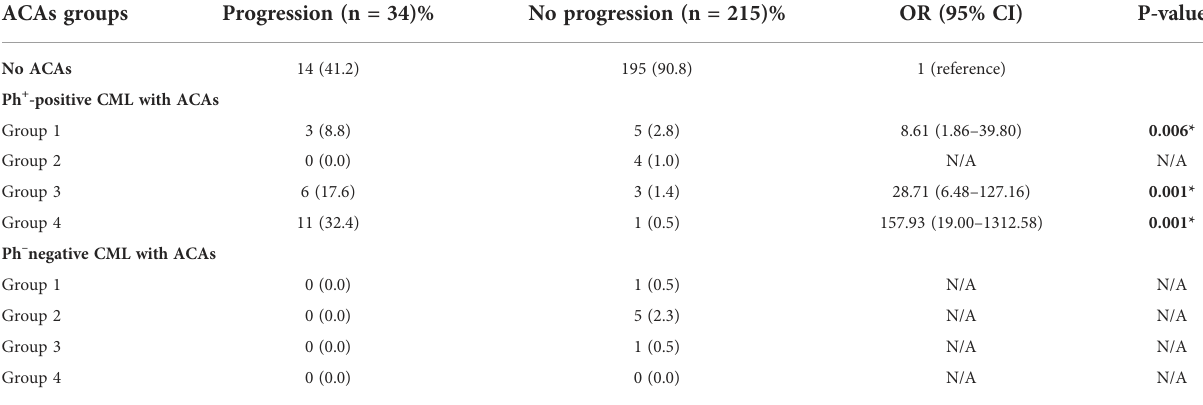
TABLE 4 Risk association of the four strati fi ed groups of ACAs with disease progression among Ph+ positive and Ph- negative CML patients. ACAs